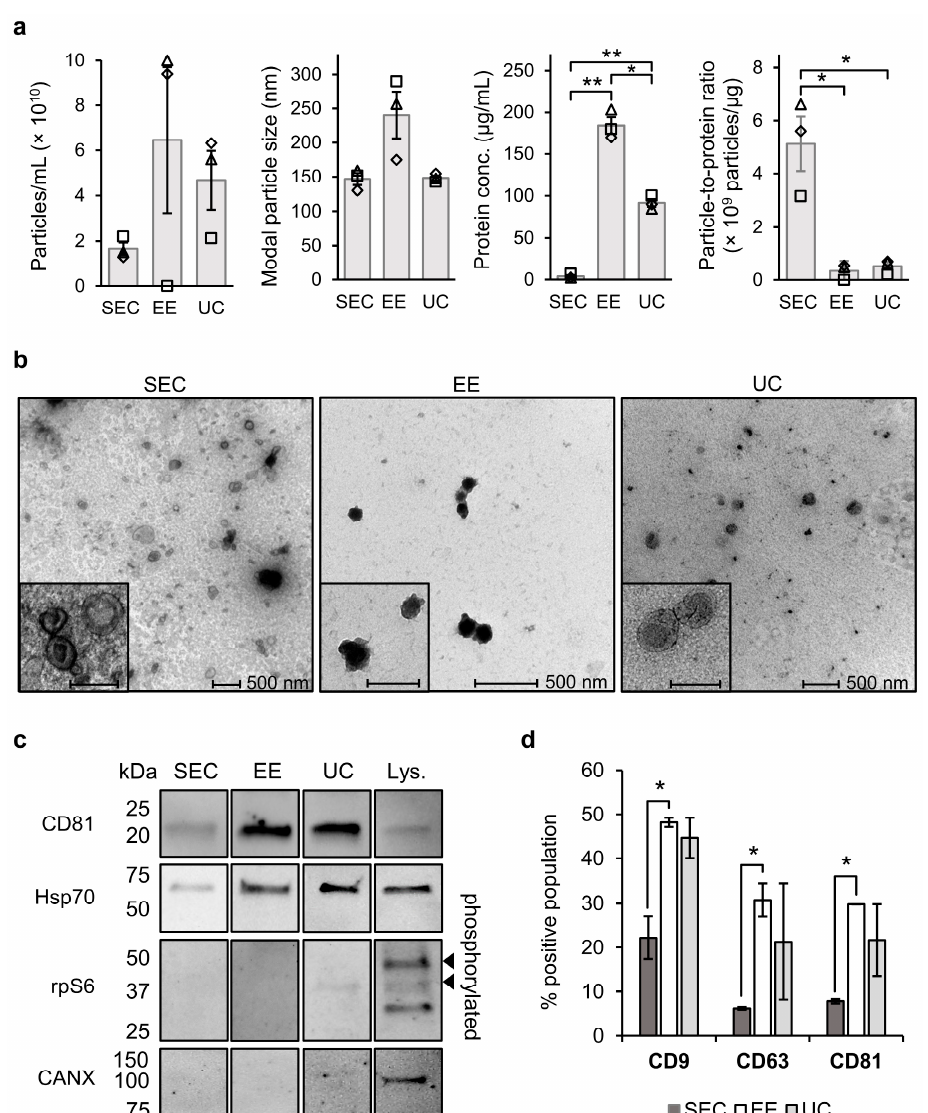
Figure 1. Characterization of H1975 small extracellular vesicles (sEVs) purified by size exclusion chromatography (SEC), in comparison with exoEasy (EE) and ultracentrifugation (UC). ( a ) Particle and protein analysis in sEV fractions isolated from conditioned cell media using SEC, EE, and UC. Particle concentrations (blank-corrected) and modal particle diameter were determined using scatter-based nanoparticle tracking analysis (NTA) using a NanoSight NS500, protein concentrations were measured using the Micro BCA™ Protein Assay Reagent Kit (SEC) and DC Protein Assay Kit (UC, EE). The results are presented as the mean ± SEM (N = 3, n = 3) or mean ± SD for SEC (N = 3, n = 1) of N experiments, each indicated by an open symbol. The blank-corrected particle-to-protein ratio was calculated as a measure of sEV purity. ( b ) Transmission electron microscopy images of sEVs represented with a scale bar of 500 nm (200 nm in insets). ( c ) Representative western blot analysis of sEV-specific protein markers (CD81, MW = 24–26 kDa and Hsp70, MW = 70 kDa) and non-sEV markers (rpS6, MW = 34 kDa and CANX, MW = 90 kDa) in sEV samples and whole H1975 cell lysate (Lys.). ( d ) Flow cytometry analysis of the percentage double positive population of CFDA-SE/CD9 (CD9), CFDA-SE/CD63 (CD63) and CFDA-SE/CD81 (CD81) versus CFDA-SE single stained sEV samples obtained using a BD Influx flow cytometer with a small-particle detector. Data is represented as mean ± SEM (N = 2, n = 3). Statistically significant results are indicated by * for p -value ≤ 0.05 and ** for p -value ≤ 0.01.